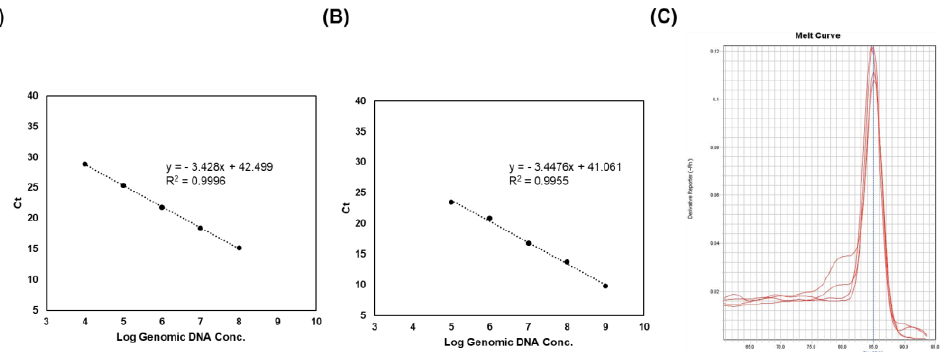
Figure 4. Real-time PCR analysis of genomic DNA, live, and heat-killed LS06 for a range of concentrations. ( A ) Standard curve of live L. sakei . ( B ) Standard curve of heat-killed LS06. ( C ) Melt curve generated by strain-specific primers in real-time PCR.